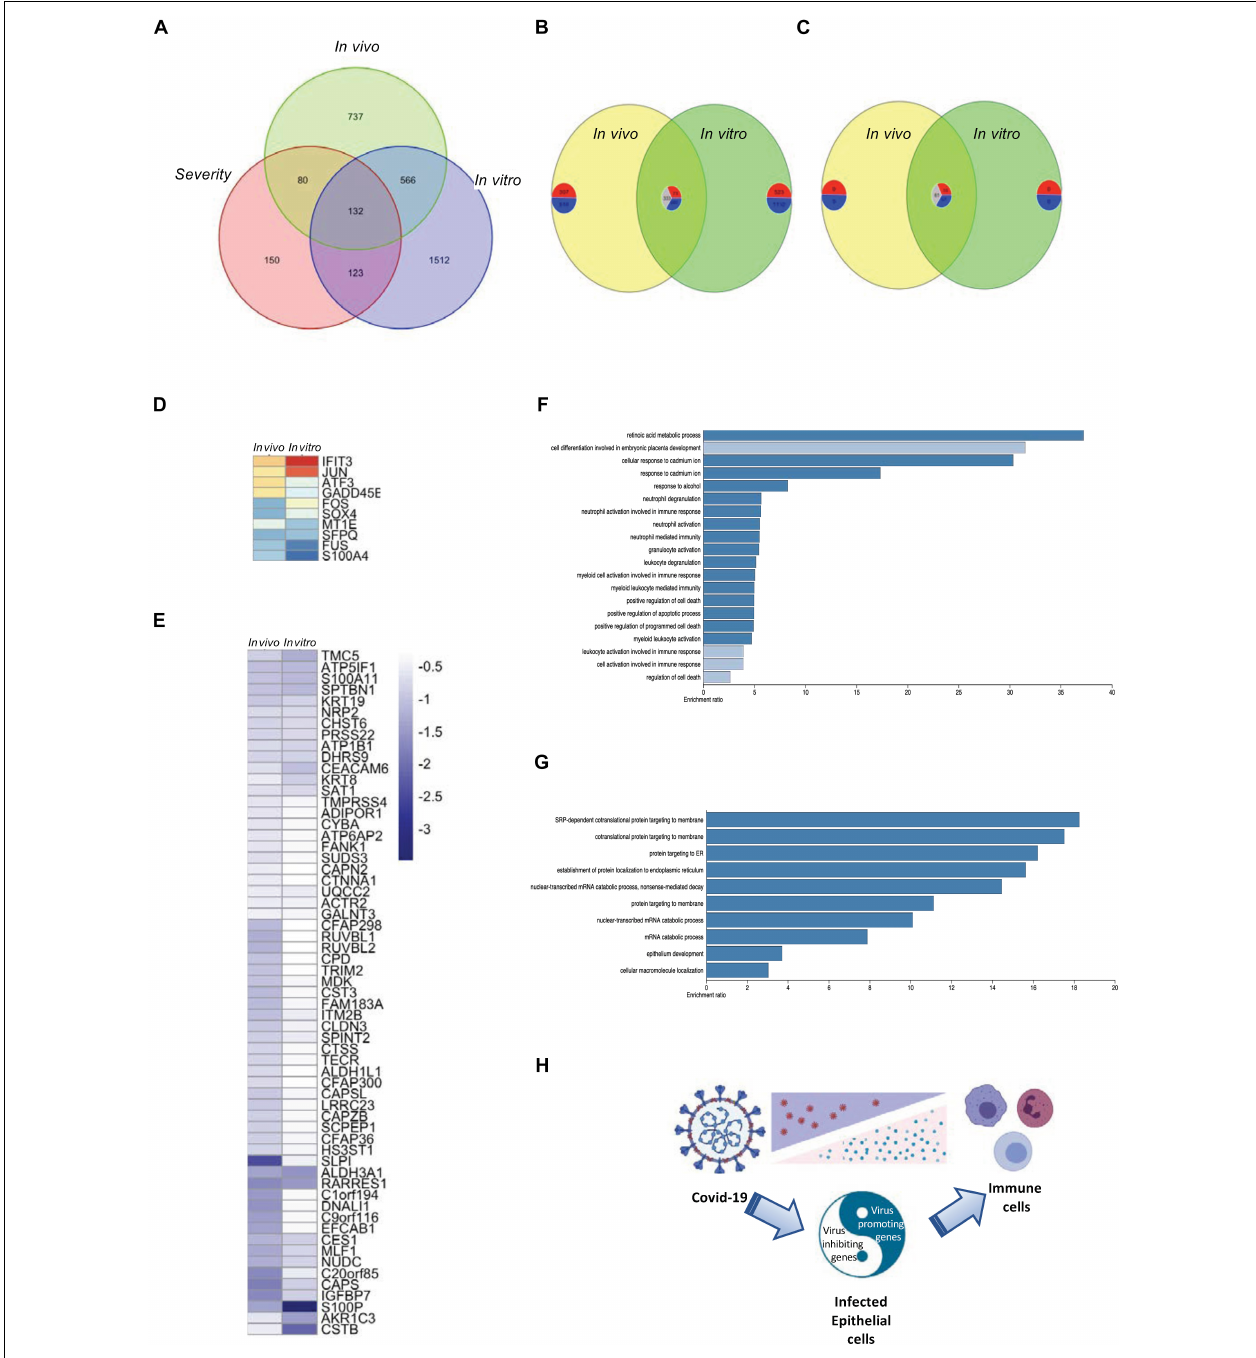
FIGURE 5 | Overlapping of in vivo and in vitro gene expression and disease severity. (A) A Venn diagram demonstrating the intersection of in vivo and in vitro SARS-CoV-2 infection-related genes and severe ARDS-related genes. (B) A Venn diagram demonstrating the shared genes of in vivo and in vitro SARS-CoV-2 infection–related genes. The number of commonly upregulated, commonly downregulated, and contra-regulated genes are shown in a clockwise manner. (C) A Venn diagram demonstrating the shared genes of in vivo and in vitro SARS-CoV-2 infection–related genes with severe ARDS-related genes. The number of commonly upregulated, commonly downregulated, and contra-regulated genes are shown in a clockwise manner. (D) A heat map demonstrating the expression levels of the commonly upregulated genes of in vivo and in vitro SARS-CoV-2 infection–related genes that were shared with severe ARDS-related genes. (E) A heat map demonstrating the expression levels of the commonly downregulated genes of in vivo and in vitro SARS-CoV-2 infection–related genes that were shared with severe ARDS-related genes. (F) A bar chart demonstrating the enriched gene ontology for the commonly upregulated or downregulated genes between in vivo and in vitro SARS-CoV-2 infection. (G) A bar chart demonstrating the enriched gene ontology for the contra-regulated genes between in vivo and in vitro COVID-19 infection. (H) A schematic graph demonstrating the balance of the virus promoting and defense genes of the SARS-CoV-2-infected epithelial cells.